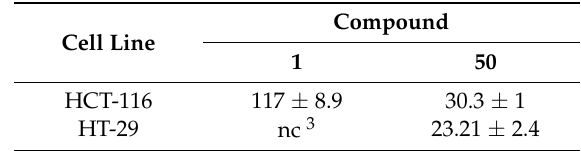
Table 8. Anticancer activities of compound 50 compared to quercetin 1,2 .